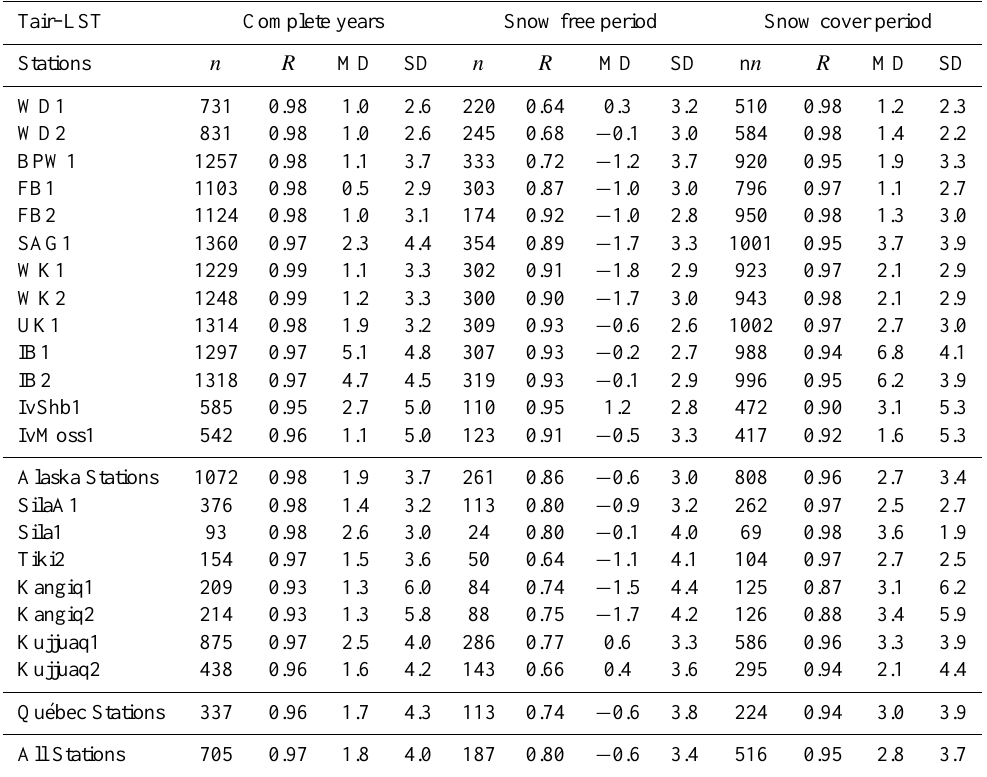
Table 8. Mean Difference (MD), Standard Deviation (SD) and Correlation ( R ) between T air and LST during complete year, snow free and snow cover periods for Aqua/Terra